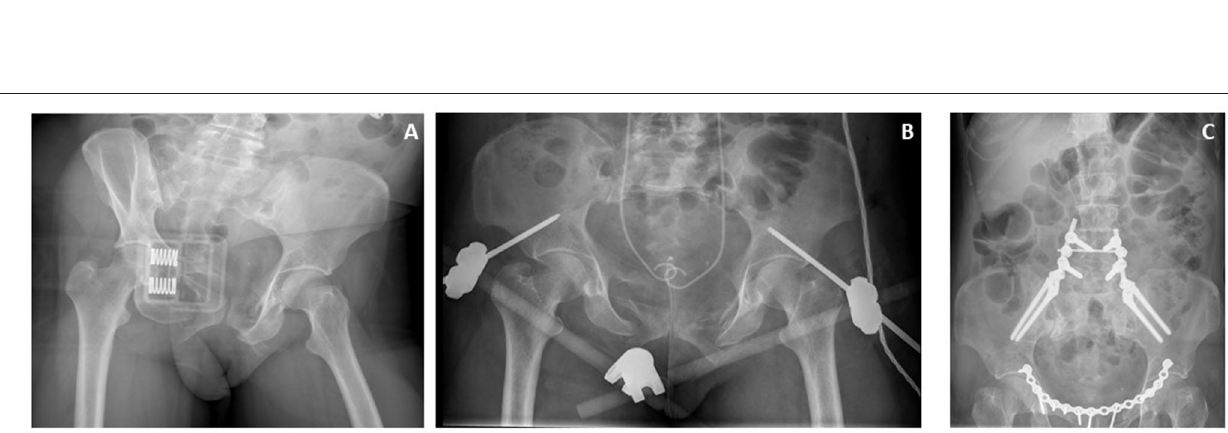
Frontiers in Surgery | www.frontiersin.org